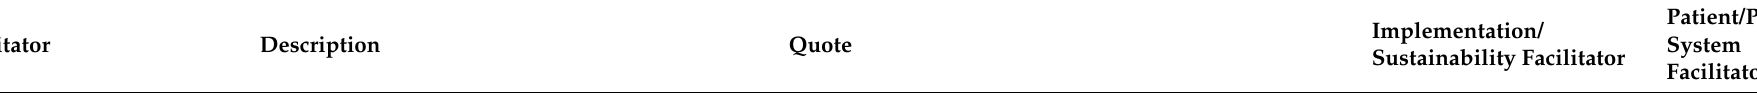
Table 3. Participant quotes demonstrating facilitators to initiative implementation and/or